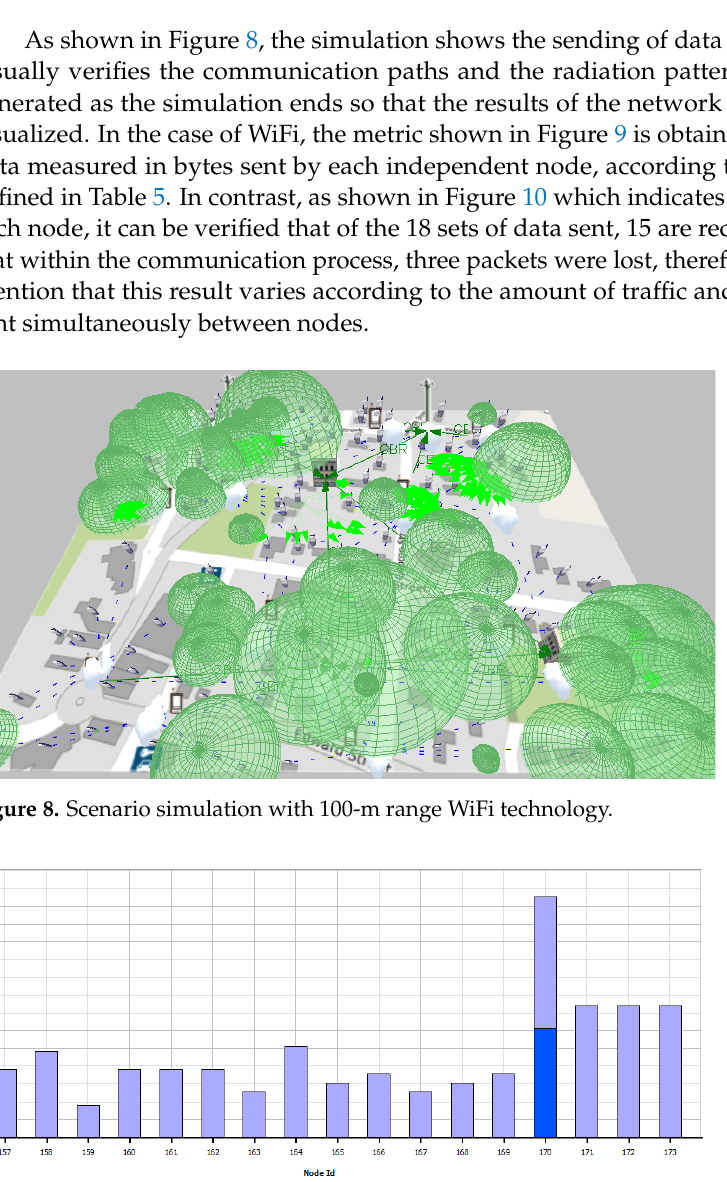
Figure 7. Zigbee network topology for simulation.